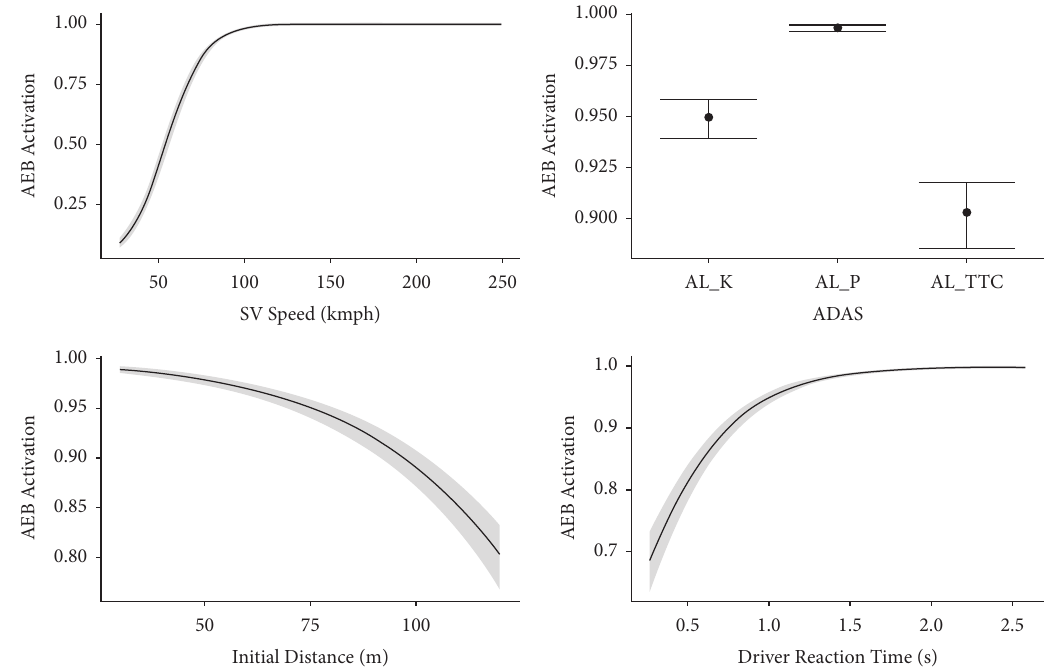
Figure 10: Effect plots for four important parameters resulted in the AEB activation model (confidence interval of